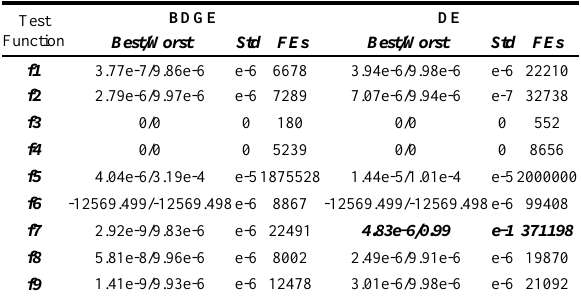
Table. 2 Comparison of results on 50-time independent random testing with benchmark